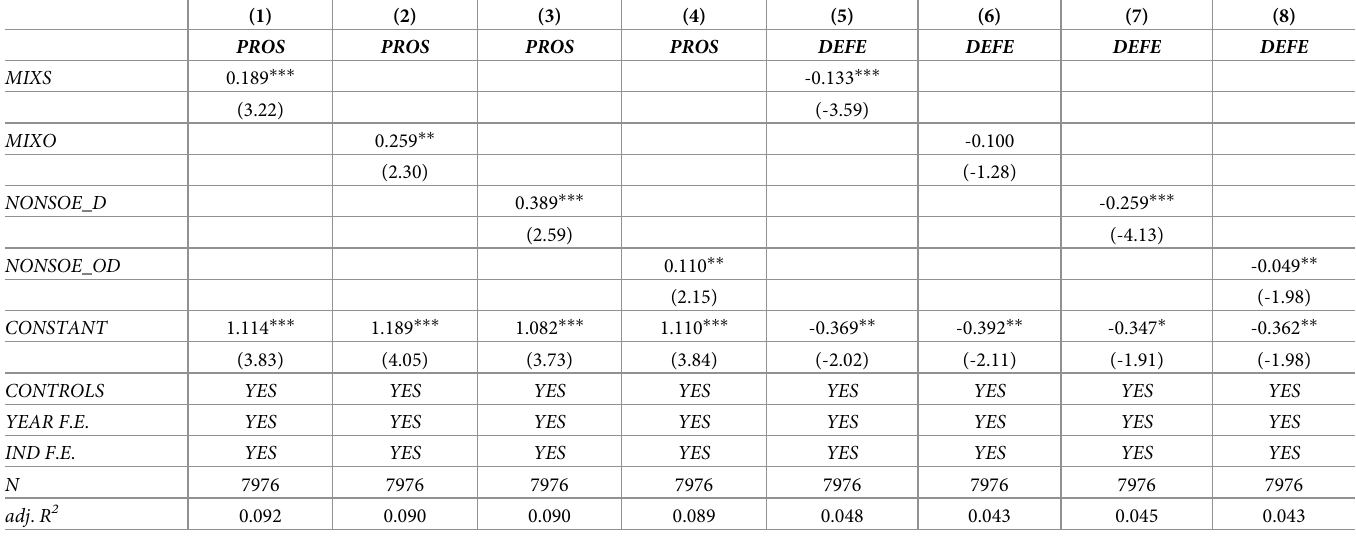
Table 7. Alternative measures of explained variable.